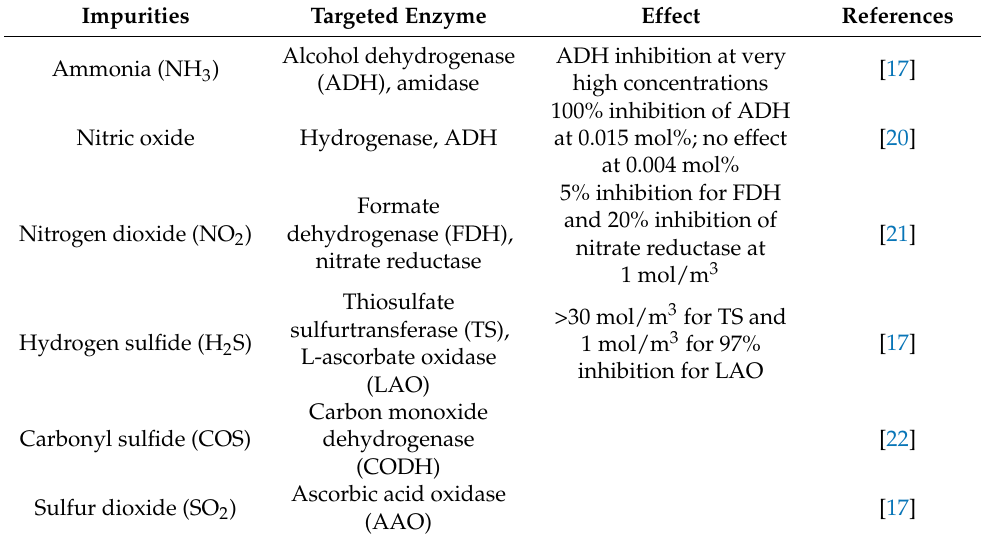
Table 1. Effect of syngas impurities on metabolic